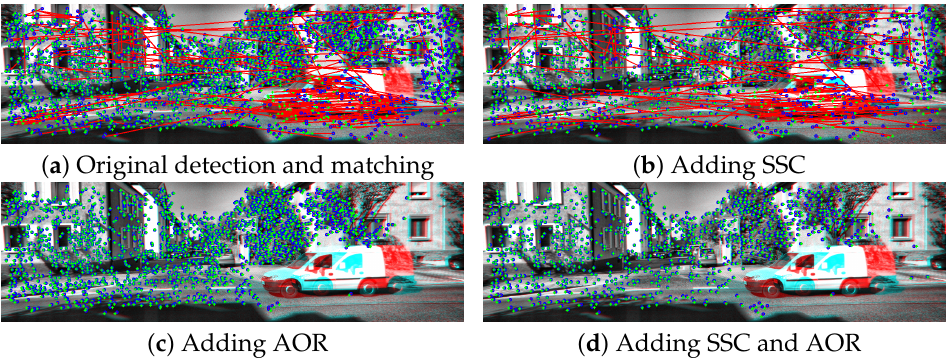
Figure 3. The effect of SSC and AOR on the features detection and matching. The previous frame is shown as the red component of I k − 1 , and the current frame is shown as the blue component of I k . The green crosses (+) and the blue circles ( ◦ ) represent the features F k − 1 and F k , respectively. Finally, the red lines represent the matched pairs in P k − 1: k . Each of the images represents the following: ( a ) the original feature pairs through using the SURF detector and a brute-force matching algorithm, ( b ) shows the feature pairs after adding the SSC algorithm only. ( c ) shows the feature pairs after adding the AOR algorithm only, and finally ( d ) shows the feature pairs after adding both SSC and AOR. The majority of the outliers were removed due to the large difference between the angles, as illustrated in Figure